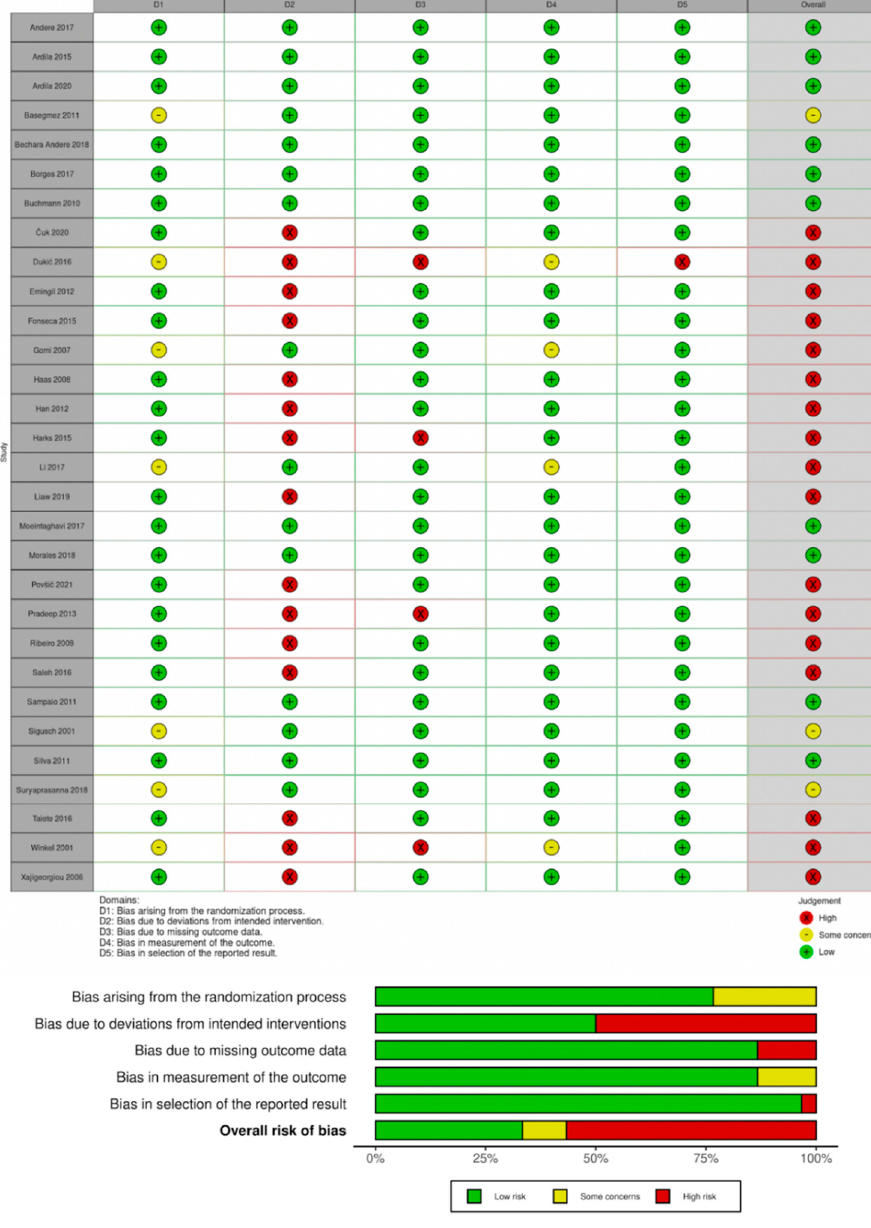
Figure 2. Risk-of-bias summary of the included studies. Andere 2017 [61]; Ardila 2015 [63]; Ardila